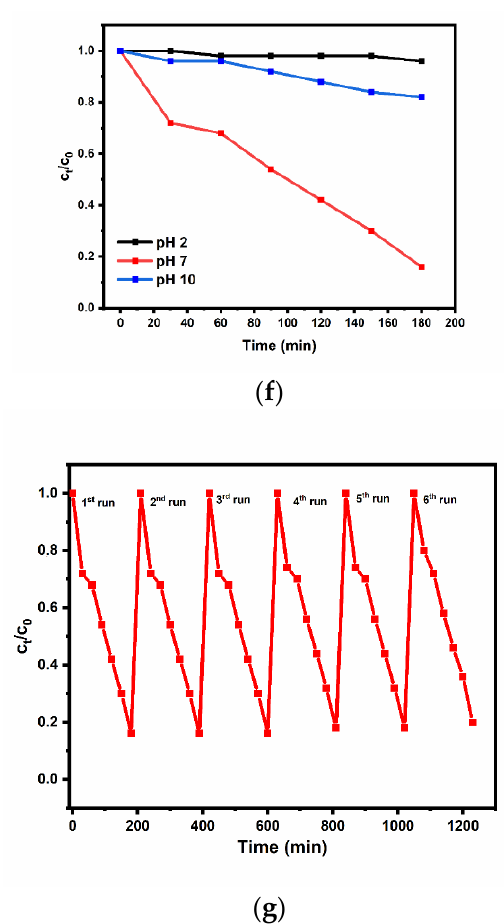
Figure 4. ( a ) UV-Vis spectra of PEC degradation of paracetamol; ( b ) normalised concentration decay versus time plot for photocatalytic, electrocatalytic and photoelectrocatalytic degradation of para- cetamol on of Bi 2 WO 6 -CNP–TiO 2 NTA electrode and ( c ) corresponding kinetics plots; ( d ) normalised concentration decay versus time plot for PEC degradation of Paracetamol on of Bi 2 WO 6 -CNP–TiO 2 NTA electrode. ( e ) Effects of current density and ( f ) pH on the degradation of paracetamol. ( g ) Re- usability cycle experiments for the degradation of paracetamol on of Bi 2 WO 6 -CNP–TiO 2 NTA elec- trode.